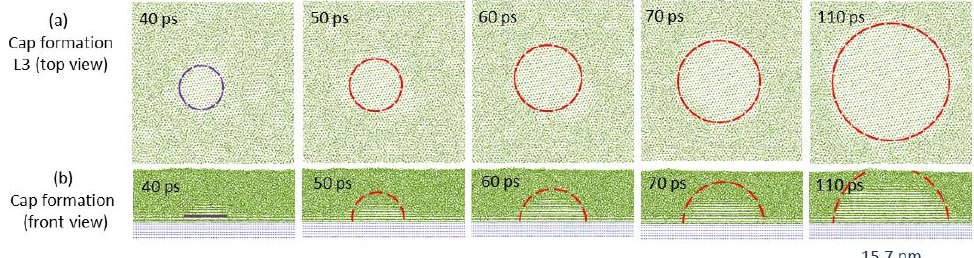
Figure 13. Time-averaged atomic positions of a simulation system with 8% lattice misfit demon- strating the unconstrained cap formation process at a constant temperature. Nucleation occurred at Δ T n = 131 K on a substrate of 2r N = 8.9 nm to provide the 2D nucleus of 2r n = 4.3 nm (the purple dashed circle at t = 40 ps). With increasing time, the 2D nucleus grows isothermally initially into a spherical cap ( t = 50 ps) and then hemispheres with increasing radius ( t > 60 ps).